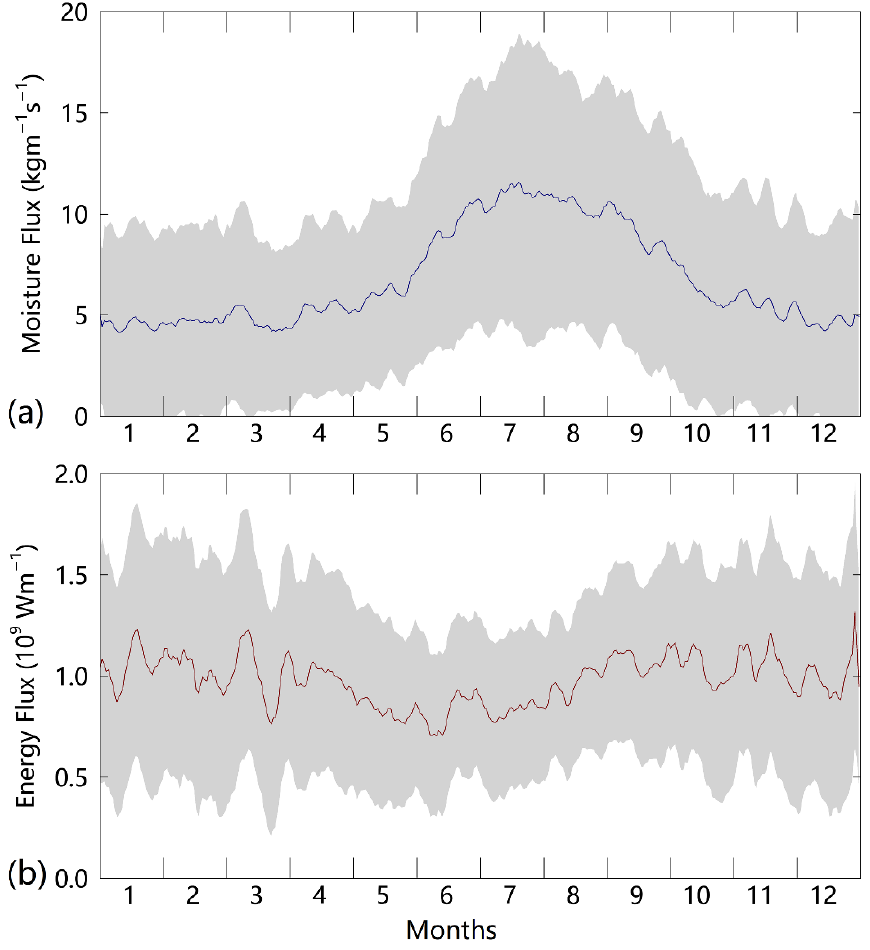
Figure 3. Seasonal variations in whole-layer ( a ) meridional moisture fluxes and ( b ) total energy fluxes across 70 ◦ N averaged over 1979 to 2020. The fluxes were obtained from the ERA5 product. Shading represents the mean plus/minus one standard deviation.